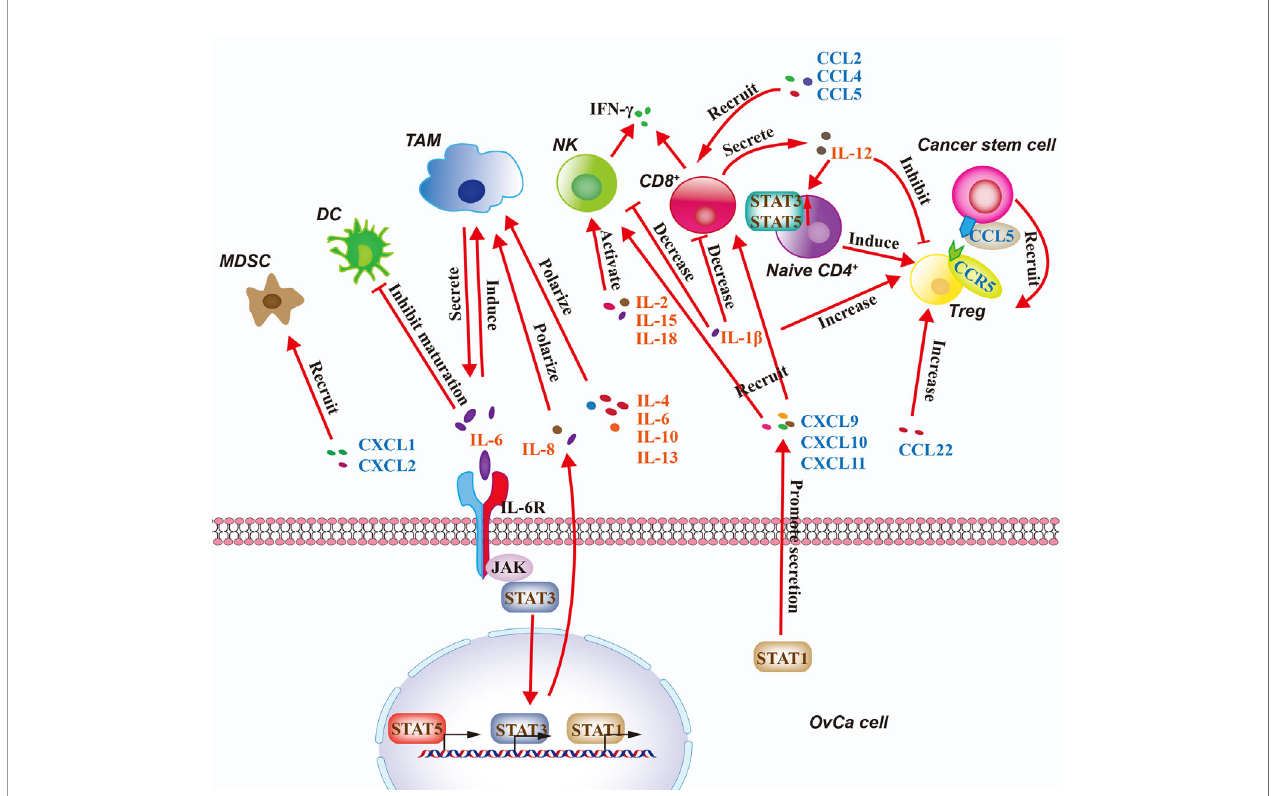
FIGURE 3 | Regulation of the Immune Microenvironment in OvCa by Cytokine Signaling. Cytokine signaling pathways in the ovarian cancer (OvCa) tumor microenvironment include interleukins, chemokines, with intracellular regulation via STAT1/3/5. Immune cells and OvCa cells interact through cytokines and STATs to generate a comprehensive network at the tumor site. CSC, cancer stem cell; DC, dendritic cell; CD4 + , CD4-expressing T cell; CD8 + , CD8-expressing T cell; MDSC, myeloid-derived suppressor cell; NK, natural killer cell; TAM, tumor-associated macrophage; Treg, regulatory T